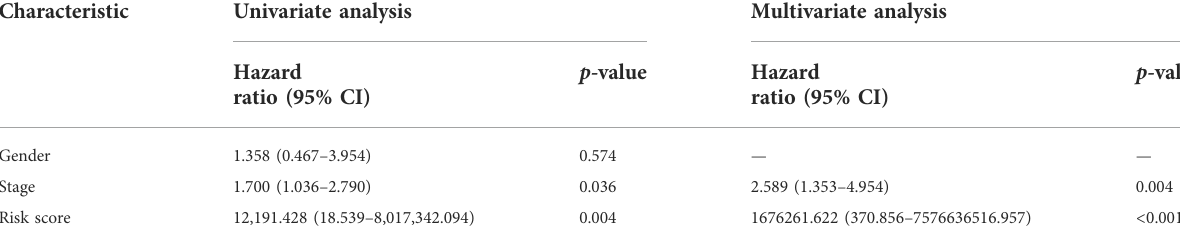
TABLE 3 Univariate and multivariate regression of CR signature and other clinical features in validation cohort.